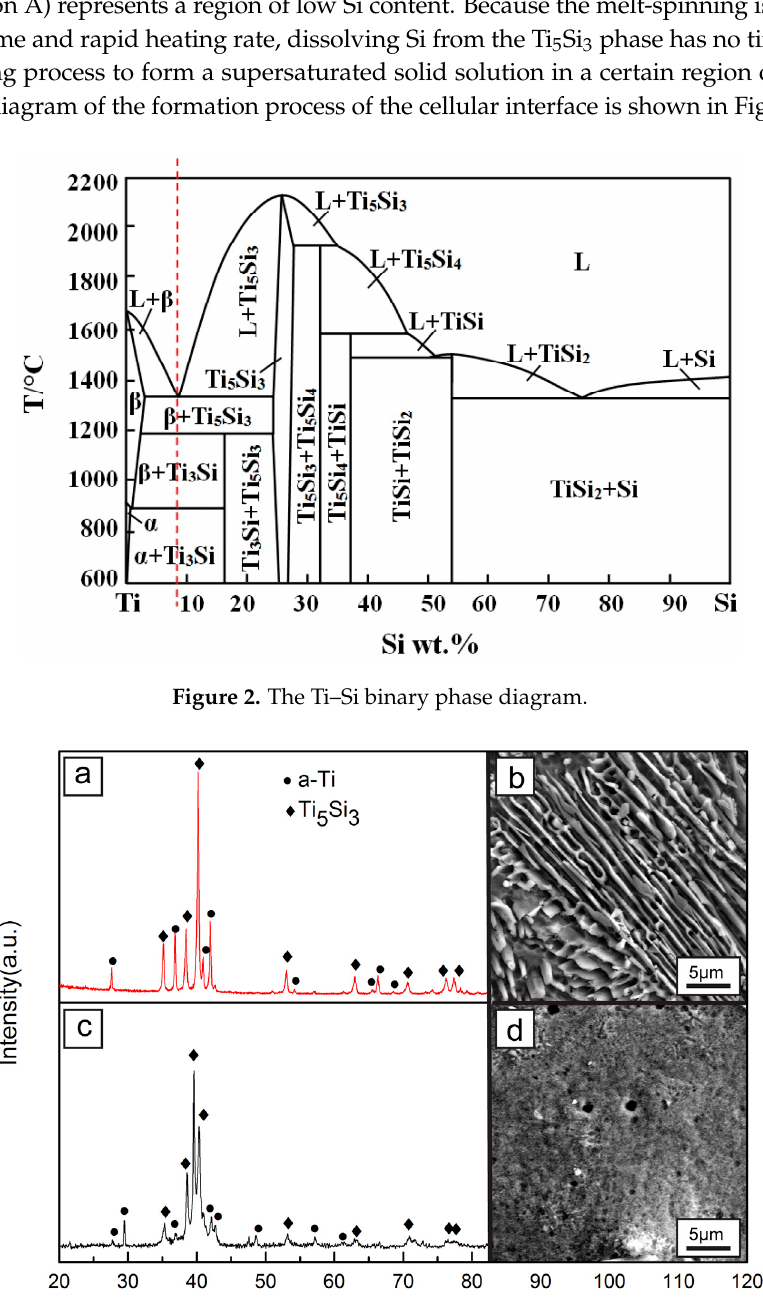
Figure 3. X-ray diffraction (XRD) patterns and scanning electron microscope (SEM) images of the in situ Ti 5 Si 3 /Ti composite inoculants: ( a ) XRD patterns of Ti–Si master alloy; ( b ) SEM image of Ti–Si master alloy; ( c ) XRD patterns of inoculants ribbons; ( d ) SEM image of inoculants ribbons.